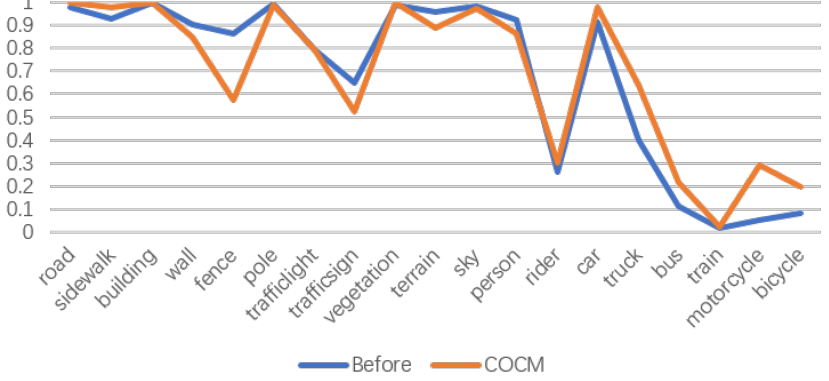
Figure 10. Category co-occurrence comparison. The blue line represents the vanilla method and the yellow line represents the COCM